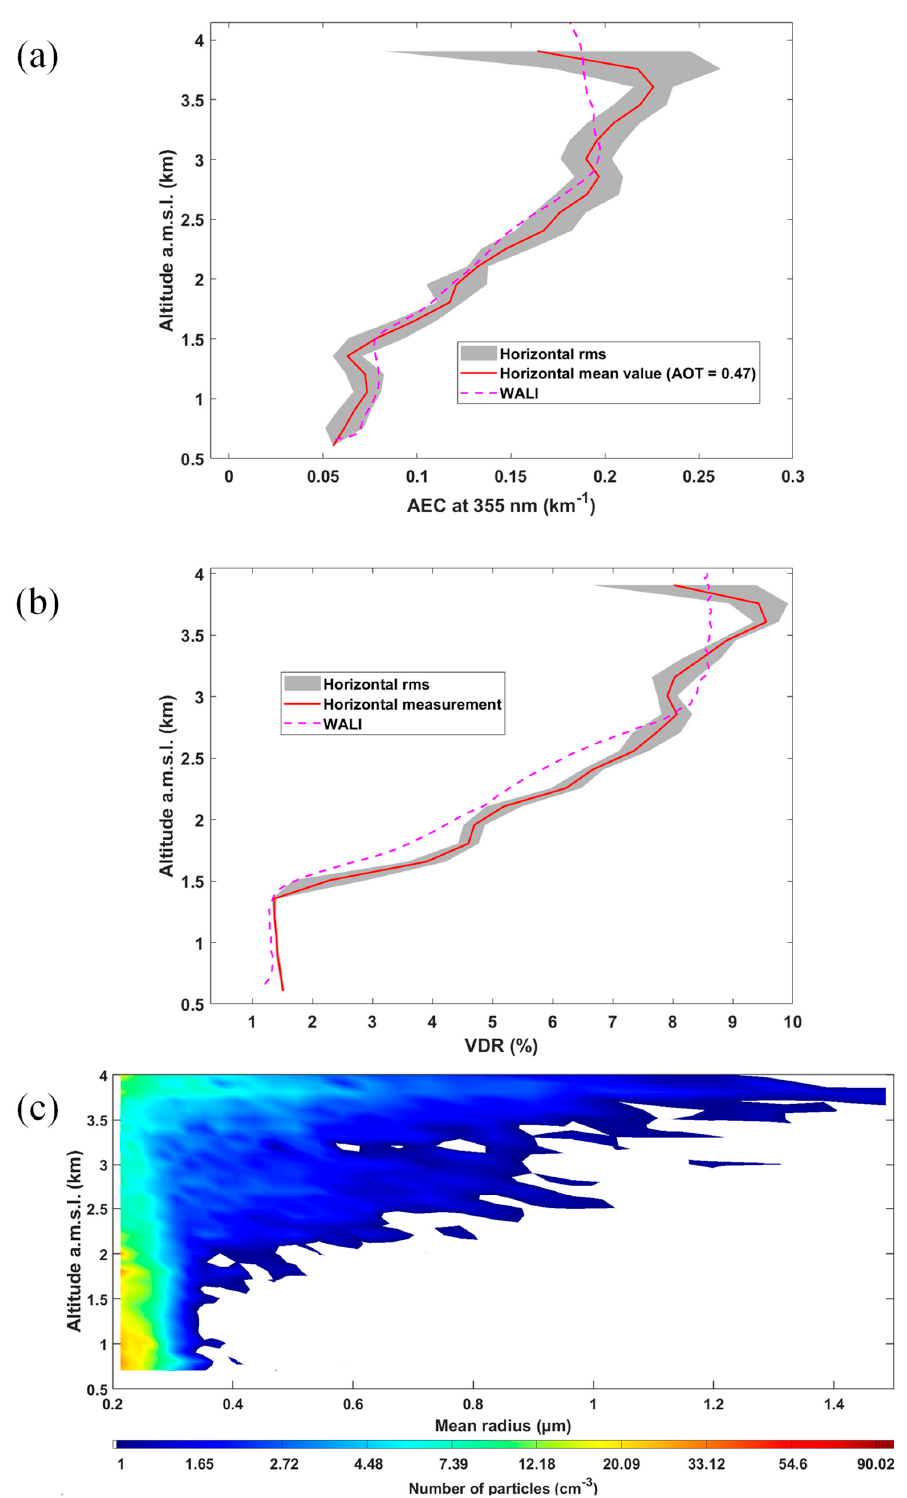
Figure 8. Measurements performed on 14 June 2019, 17:30–18:30 LT. ( a ) Vertical profile of aerosol extinction coefficient (AEC) derived from the ground-based lidar (WALI, pink dotted line) and the airborne lidar ALiAS (solid red line). ( b ) Same as a) for the linear volume depolarization ratio (VDR). The gray areas correspond to the statistical variability (rms). ( c ) Aerosol size distribution, as measured by the airborne particle sizer.